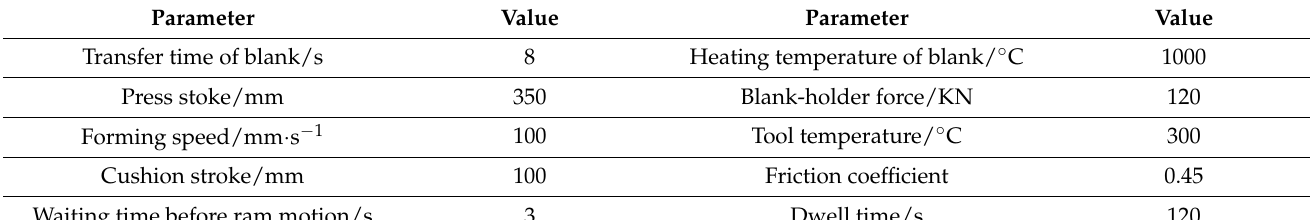
Table 3. Hot stamping process parameters of the GH3625 sheet.